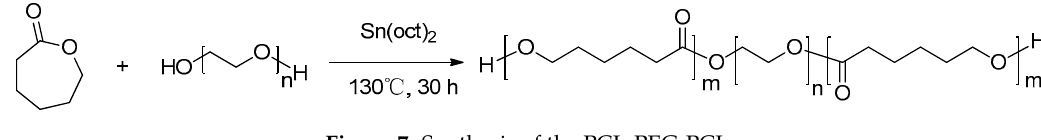
Figure 7. Synthesis of the PCL-PEG-PCL.